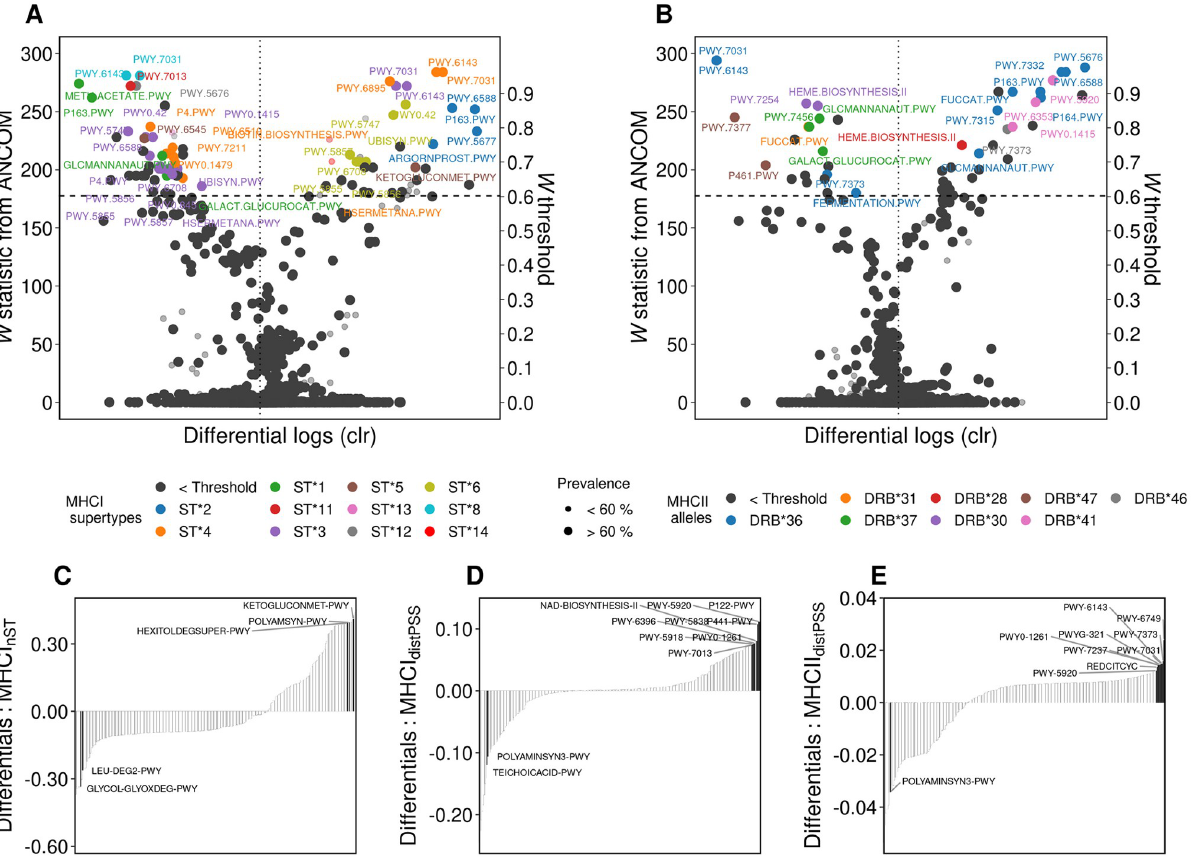
Fig 6. MHC diversity is associated with composition of functional pathways. Association between specific MHCI supertypes and MHCII alleles and metabolic pathways (A-B) . Significance threshold is informed by W statistic (horizontal dashed line) and F estimates (vertical dotted line). Metabolic pathways above this threshold represent pathways significantly ( P < 0.005) associated with a specific MHC motif. Pathways are colored according to their association with a MHC motif. (C-E) Microbial pathway ranks based on multinomial regression coefficients sorted by their association